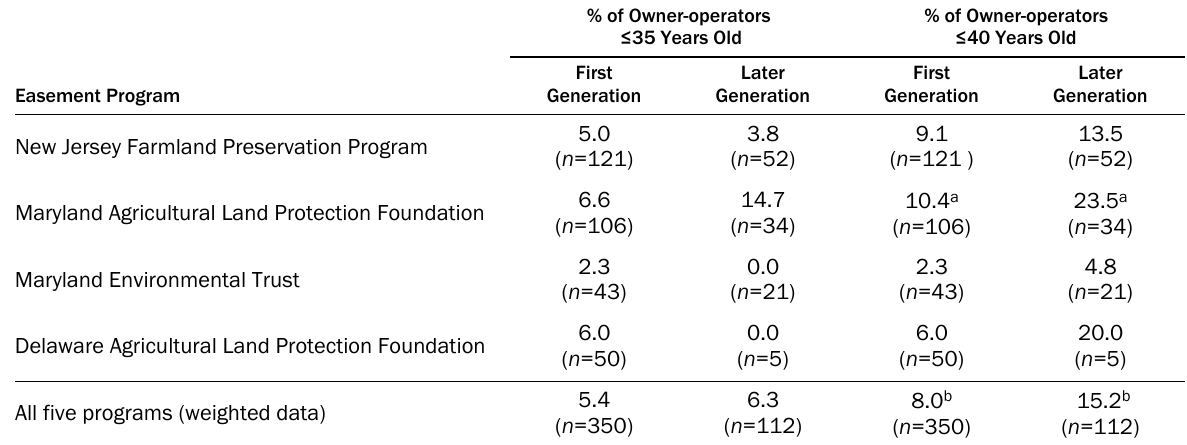
Table 4. Young Farmer Ownership of Preserved Land, by Generation of Ownership